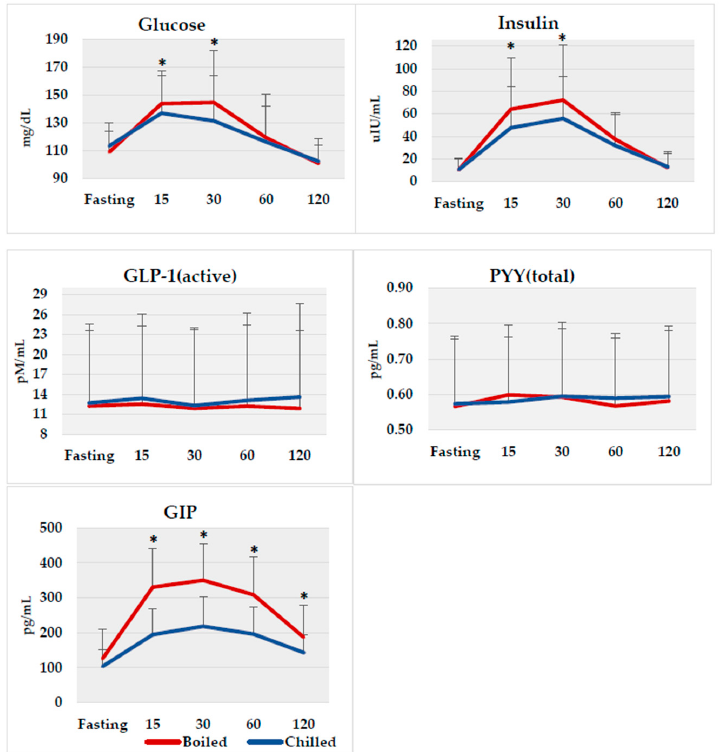
Figure 2. Biomarker responses from fasting to 120 min following boiled (red line) and chilled (blue line) potato intake. * p < 0.05 between groups using non-parametric Wilcoxon Signed Ranks Test. GLP-1, glucagon-like peptide-1; PYY, peptide YY; GIP, glucose-dependent